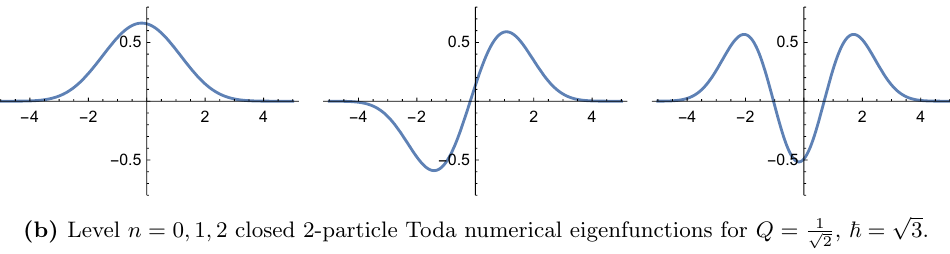
Figure 1. 2-particle closed Toda numerical